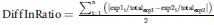
Performance of the two statistical methods on real data from the cultured mammary epithelial cell line MCF10A and the breast cancer cell line MCF7.(A) Venn diagram of APA site-switching genes detected by the chi-squared method and linear trend method between MCF10A and MCF7 (FDR<0.01). (B) Comparison of the differential APA site usage of genes between the three groups shown. DiffInRatio = ∑i = 1nexp1i/totalexp1-exp2i/totalexp22, where i refers to the i-th APA site in a gene. (C) Comparison of the change in the normalized average 3’-UTR length of genes between the three groups. The normalized 3’-UTR length for a gene was calculated by dividing the average 3’-UTR length by the most distal 3’-UTR length of this gene, and the change of the normalized average 3’-UTR length was calculated as the difference of normalized 3’-UTR lengths. Asterisks indicate the results of Wilcoxon rank sum test comparisons: (**) P<0.0001.